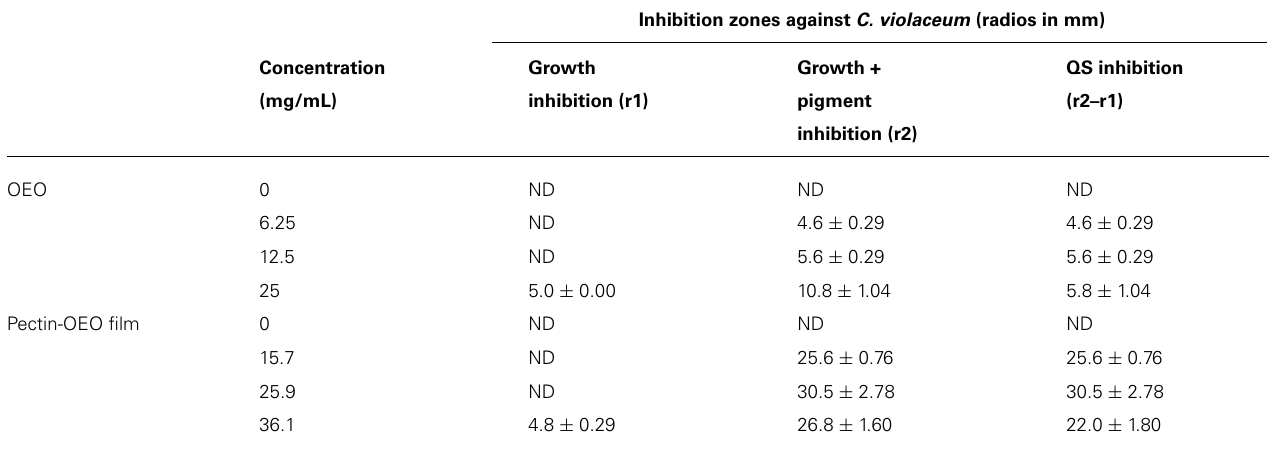
Table 3 |Anti-QS activity of OEO and pectin-OEO films by disk diffusion method using C. violaceum as indicator